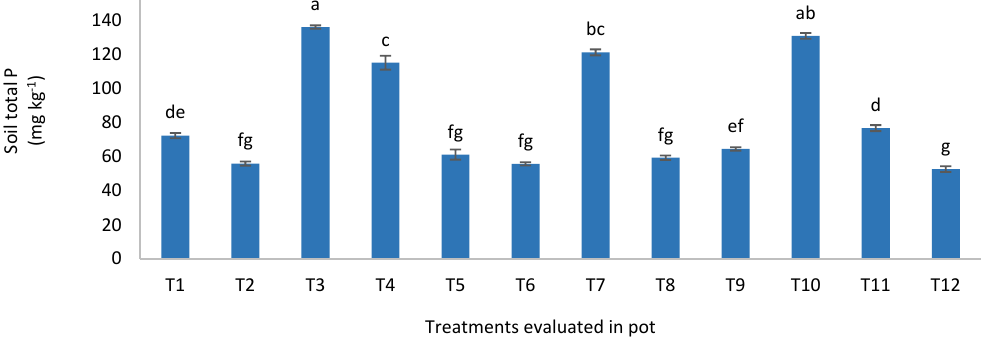
Figure 8. E ff ects of treatments on soil pH in KCl. Di ff erent letters indicate significant di ff erence between Figure 8. Effects of treatments on soil pH in KCl. Different letters indicate significant difference means using Tukey’s HSD (Honestly Significant Di ff erence) test at p ≤ 0.05. The error bars are the ± between means using Tukey’s HSD (Honestly Significant Difference) test at p ≤ 0.05. The error bars standard error of triplicates. are the ± standard error of triplicates.